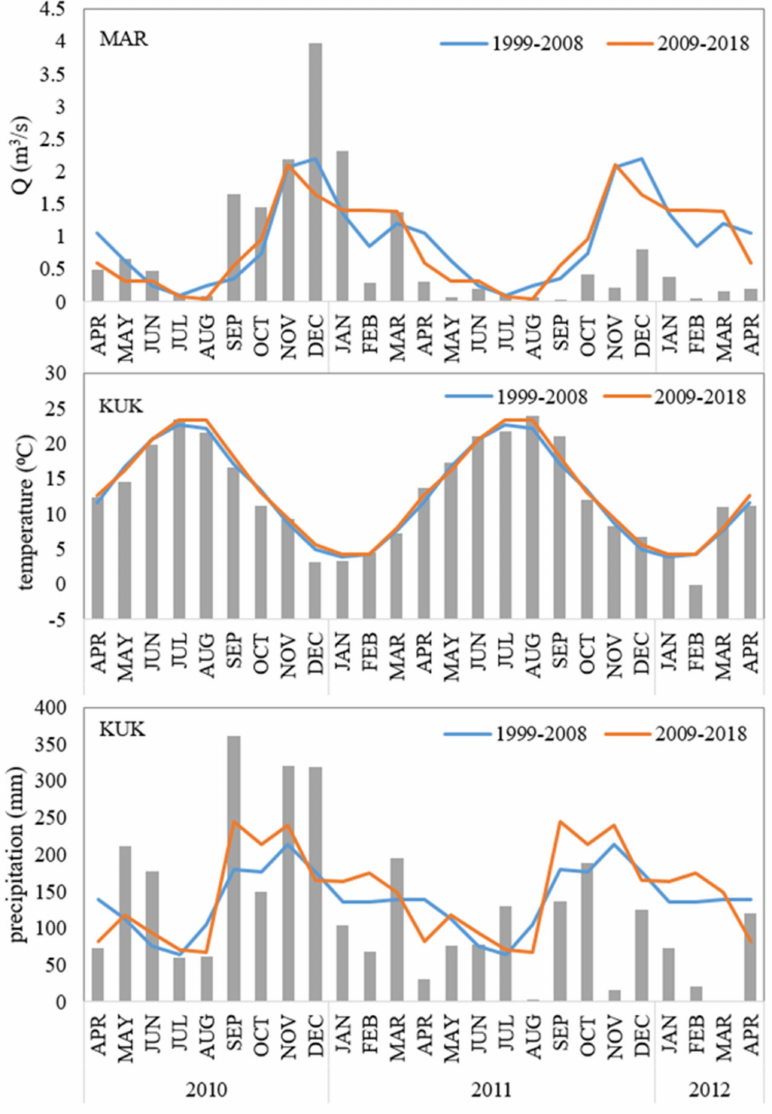
Figure 2. The bar graphs show the average monthly discharge at the Martinš´cica hydrological station (MAR, upper graph ), average monthly air temperatures ( middle graph ), and total monthly precipitation ( bottom graph ) from April 2010 to April 2012. Meteorological data are from the Kukuljanovo CMHS meteorological station (KUK). The graphs also show the monthly averages for each variable for the ten-year periods 1999–2008 (blue lines) and 2009–2018 (orange